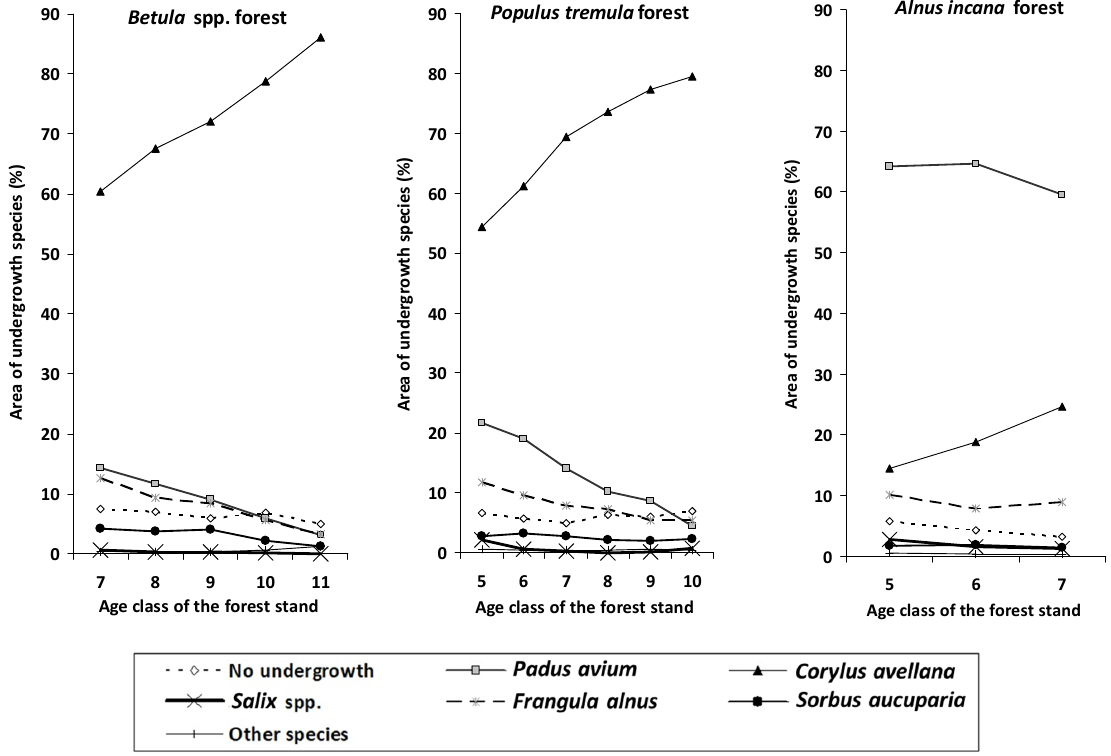
Figure 5. Changes in the undergrowth species areas in the Betula spp., Populus tremula, and Alnus incana forest stands, representing different tree age classes of the main stand story. The stand age structure shown on the y -axis means, for example, that age class 7 includes stands from 61 to 70 years old, age class 8 includes stands from 71 to 80 years old, etc. from 4.2% A to 1.2% B , but no similar trends were obtained for the Populus tremula and Alnus incana forests (Figure 5). The percentage area of Frangula alnus undergrowth decreased in the Betula (from 12.6% A to 3.3% D ) and Populus tremula (from 11.7% A to 5.3% D, E ) forests. The area of Salix spp. undergrowth decreased similarly in all studied